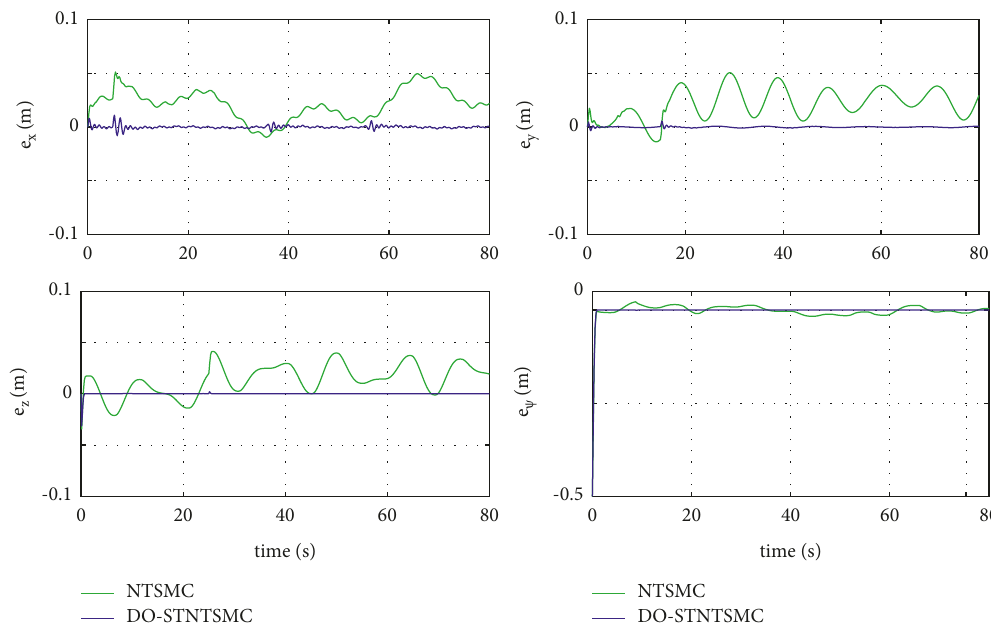
Figure 6: Evolution of the tracking errors in the first